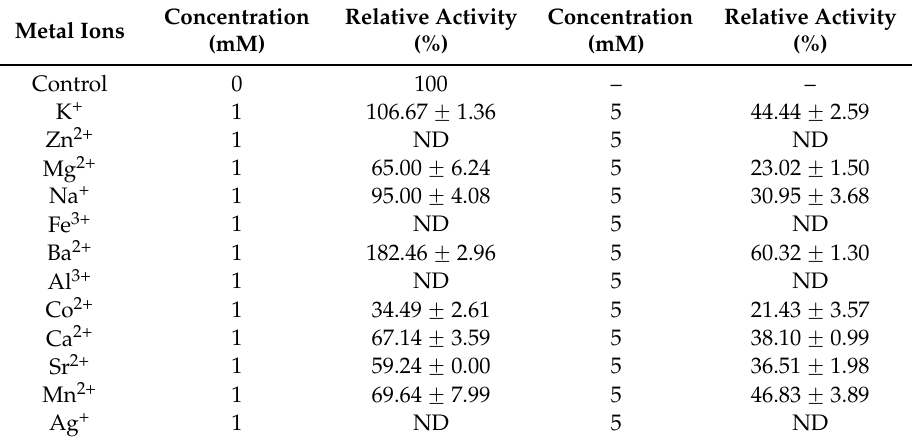
Table 4. Effect of metal ions on trypsin activity.